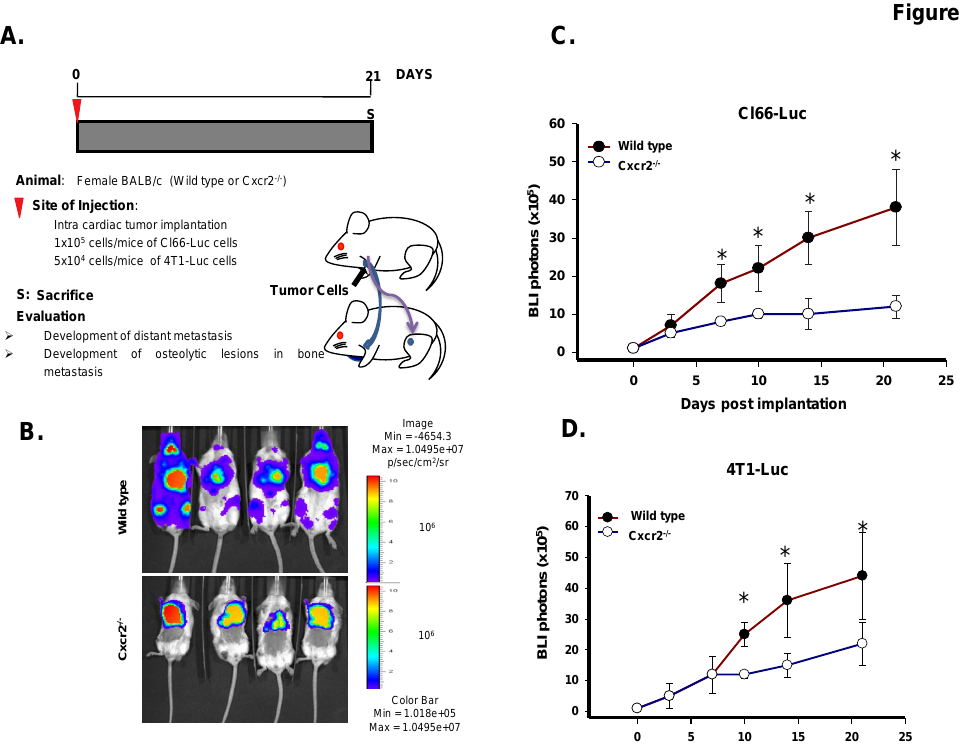
Figure 6. Host Cxcr2 influences mammary tumor bone metastasis. ( A ) Diagram depicts the schematic representation of intracardiac tumor cell injection in wild type and Cxcr2 − / − mice. ( B ) In vivo luminescent images of the wild type and Cxcr2 − / − group showing the higher spread of Cl66-Luc cells in the whole body of the wild type mice in comparison with the Cxcr2 − / − mice. ( C ) Quantification of bone metastasis burden from Cl66-Luc cells injected intracardially in wild type and Cxcr2 − / − mice based on whole body BLI imaging. The wild type mice group showed a higher tumor burden than the Cxcr2 − / − mice group. The * sign indicates p value < 0.05. ( D ) Quantification of bone metastasis burden from 4T1-Luc cells injected intracardially in wild type and Cxcr2 − / − mice based on whole body BLI imaging in wild type and Cxcr2 − / − mice. The wild type mice group showed a higher metastatic tumor burden than Cxcr2 − / − mice group. The * sign indicates p value <